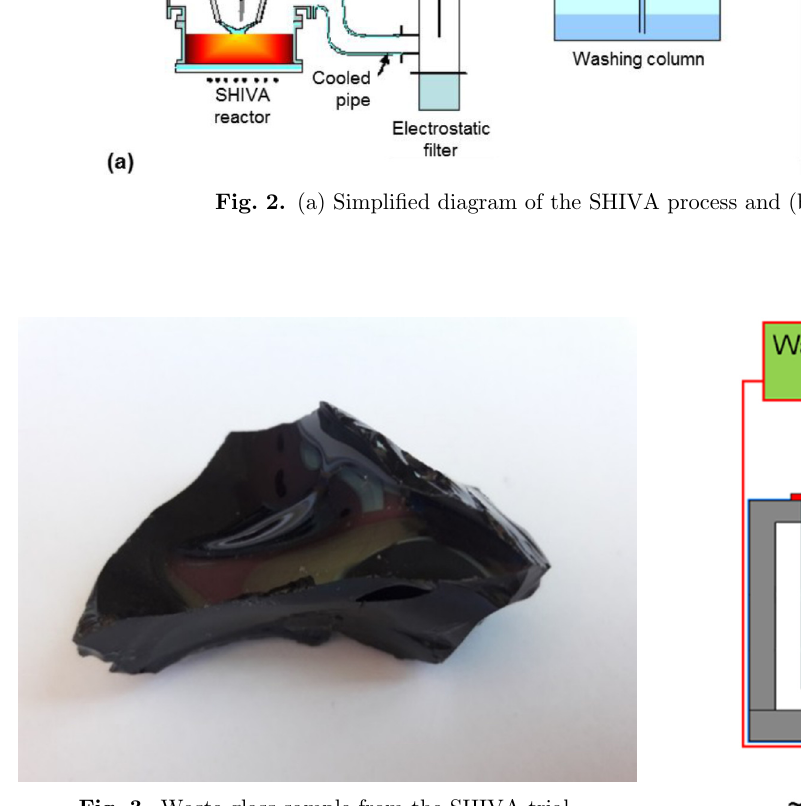
Fig. 3. Waste glass sample from the SHIVA trial.